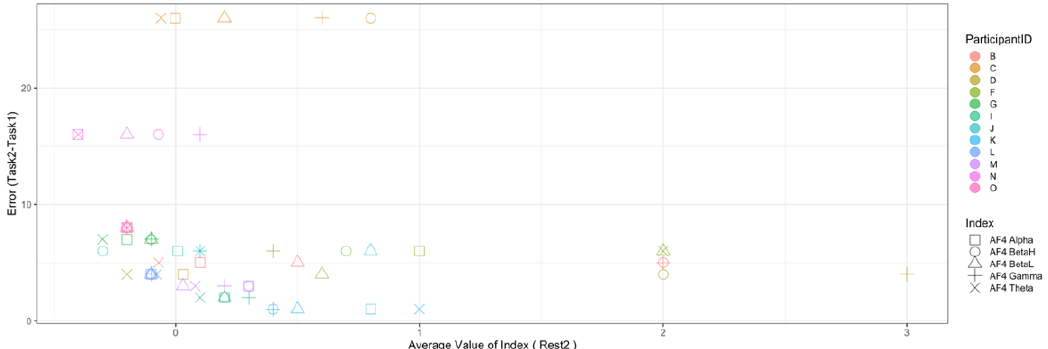
Figure 13. Scatterplot between the number of errors of Task2 vs. the EEG indexes during Rest2. (Note that the scatterplots include only EEG channels with significant correlations (AF3, P8, F4, and AF4), as summarized in Table 17).